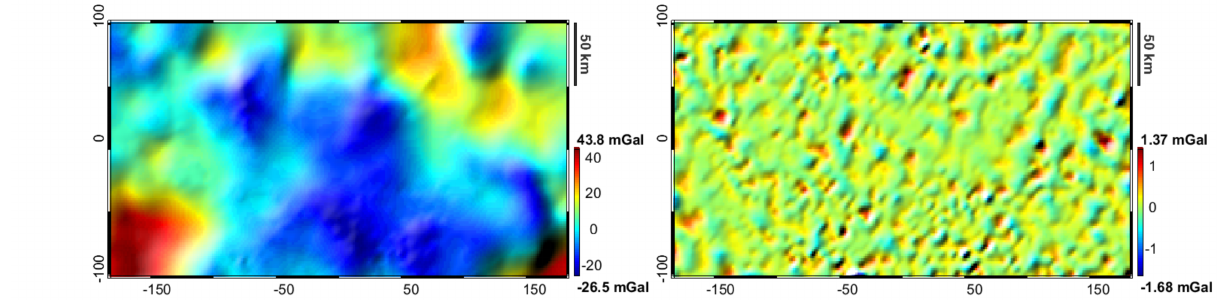
Figure 10. Example of two profiles (AA’ and BB’ in Figure 1) for Scenario 2 inversion. Solid black lines represent discontinuity between different geological units, dashed lines represent uncertainty, colours represent density in kg/m 3 .